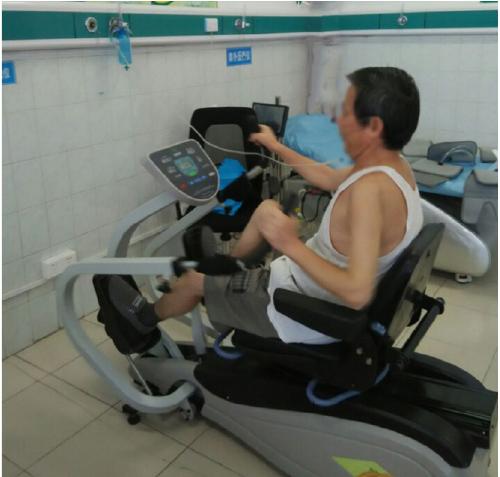
Figure 1. COPD volunteers was performing exercise training on the TBRS while inhaling